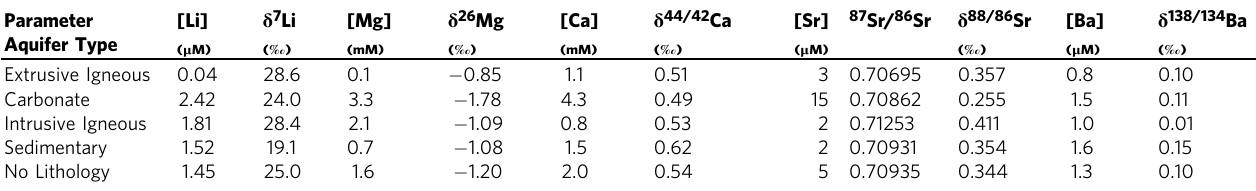
Table 2 Geologic aquifer type endmember compositions and model outputs of global groundwater